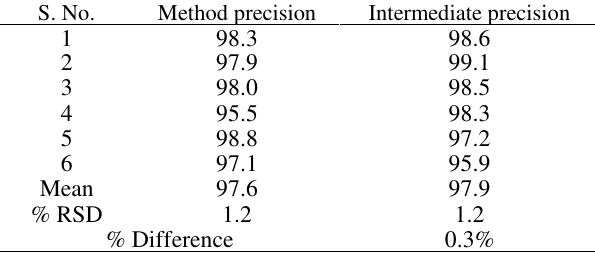
Table 2. Method precision and intermediate